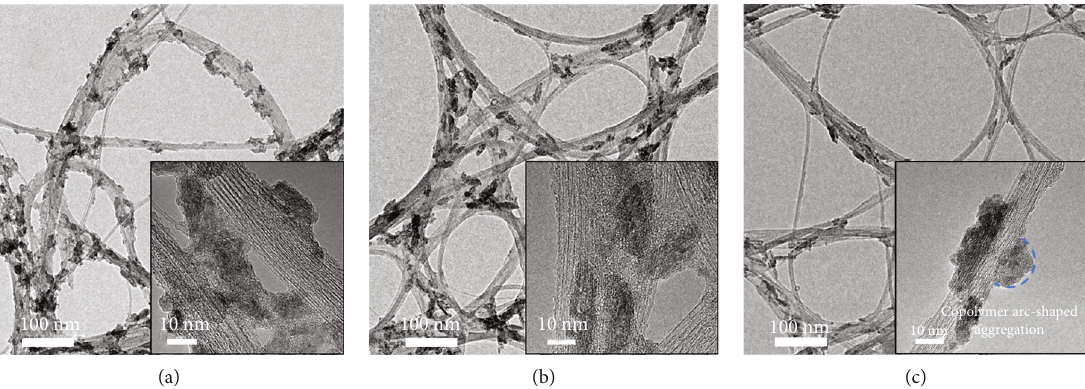
Figure 1: HR-TEM images of the modi fi ed SWNTs: PDMA- b -PMA-Th/SWNTs (a), PDMA- b -PMA- b -PEDOT/SWNTs (b), and P5- 5/SWNTs (c). The insets show the morphology of PDMA- b -PMA-Th, PDMA- b -PMA- b -PEDOT, and P5-5 surrounding the surface of the CNTs in (a), (b), and (c),